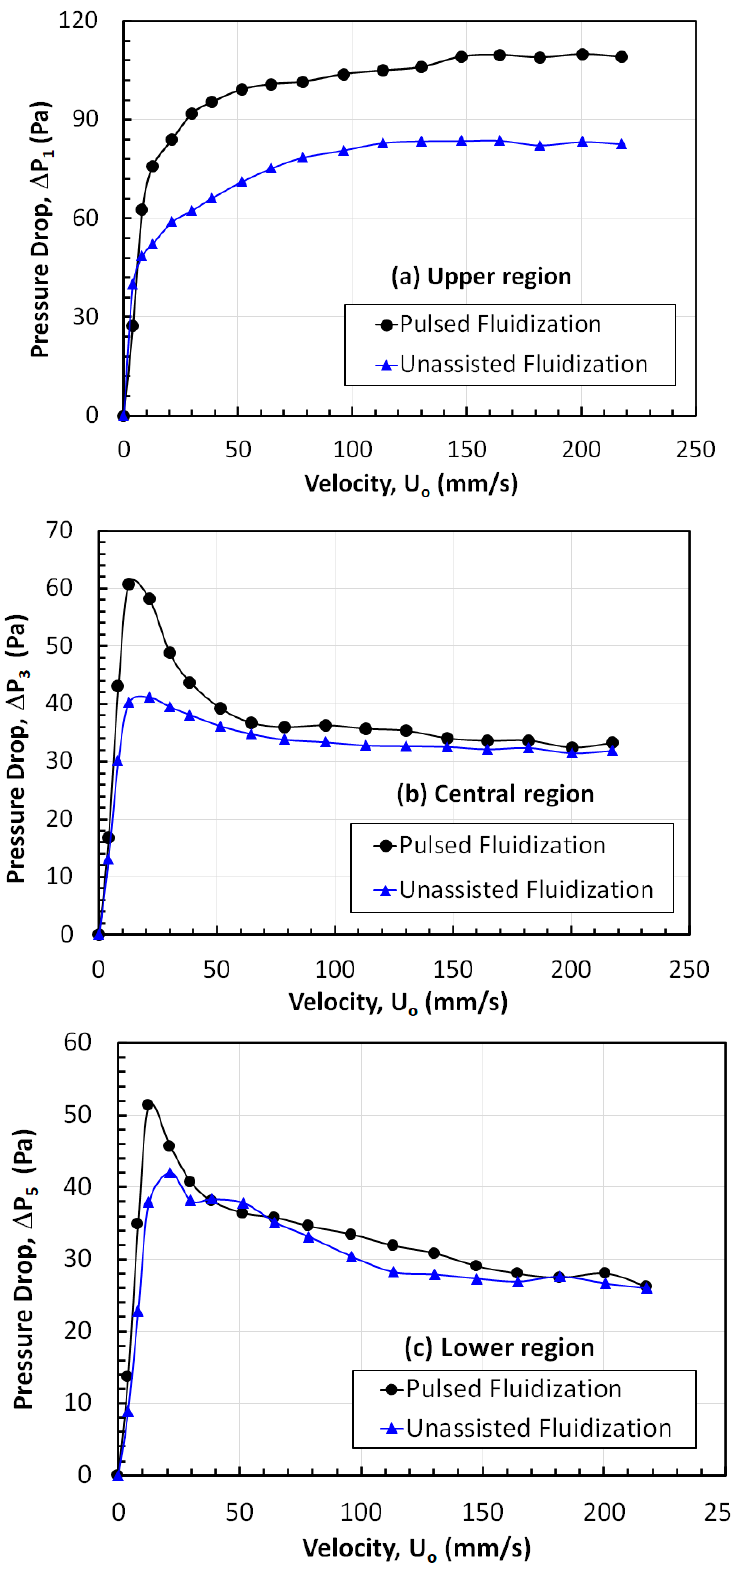
Figure 11. Effect of the velocity on the local pressure drop profiles for unassisted and pulsed fluidized beds during the fluidization cycle, a ) upper region, b ) central region, and c ) lower region.